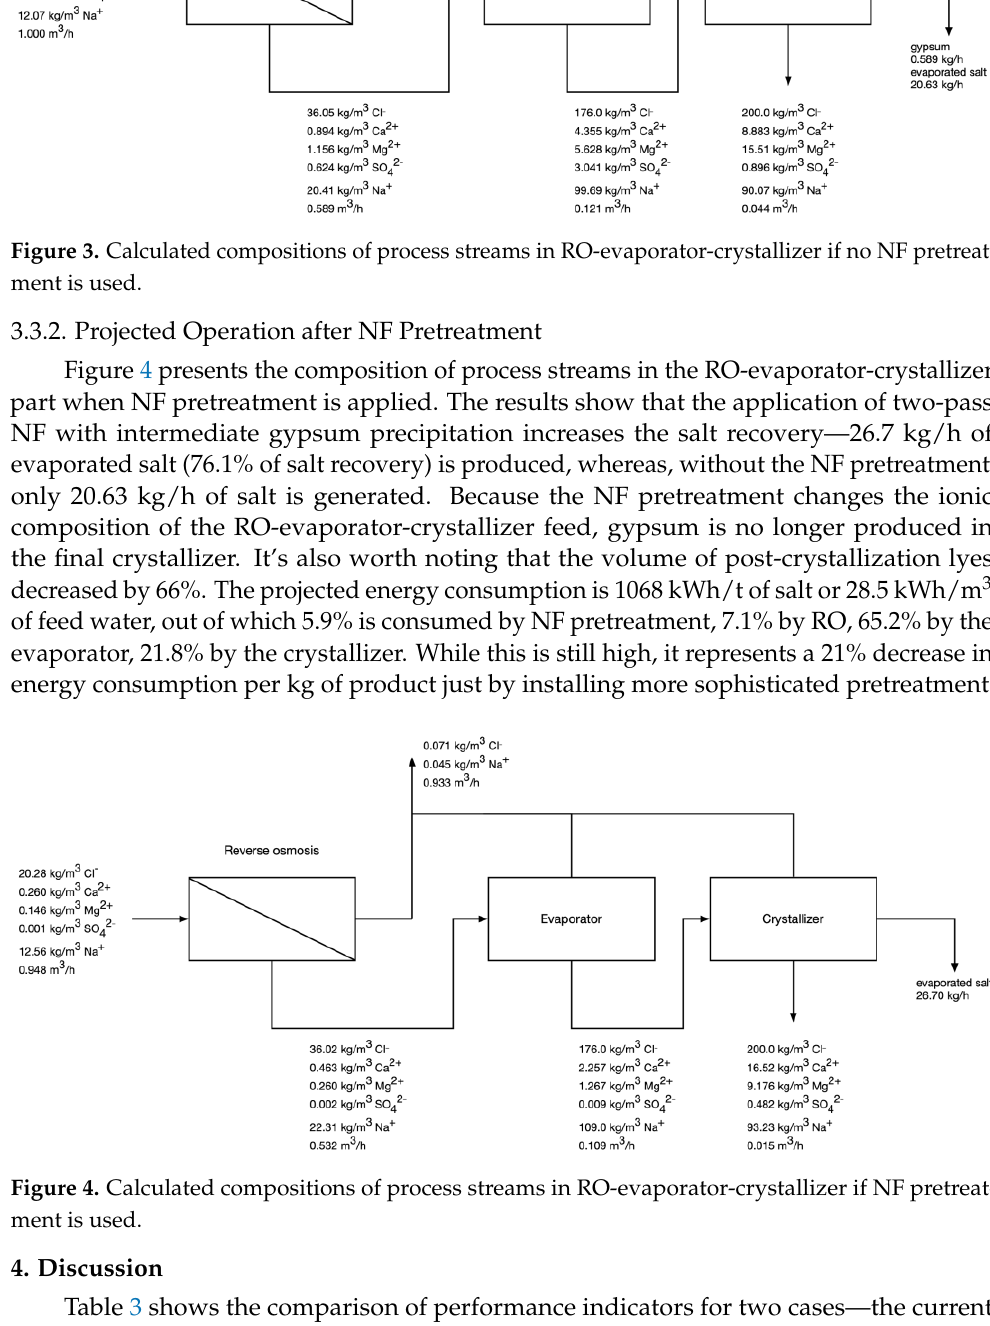
8 of 12 Figure 2. Calculated compositions of process streams in the two-pass NF system. 3.3. Modelling of RO-Evaporator-crystallizer System 3.3.1. Current Dębieńsko Operation The composition of process streams when no NF pretreatment is used (the same tech- nology as the current Dębieńsko operation) is presented in Figure 3. The results show why the bivalent impurities are a big issue in the Dębieńsko technolo gy. While the feed water carries 35.1 kg/h of NaCl (calculated based on chloride concentration), only 20.64 kg/h ends up as a product – the salt recovery is only 58.8%. Because bivalent impurities are not removed from the feed water, the crystallizer also produces gypsum. The technology gen-